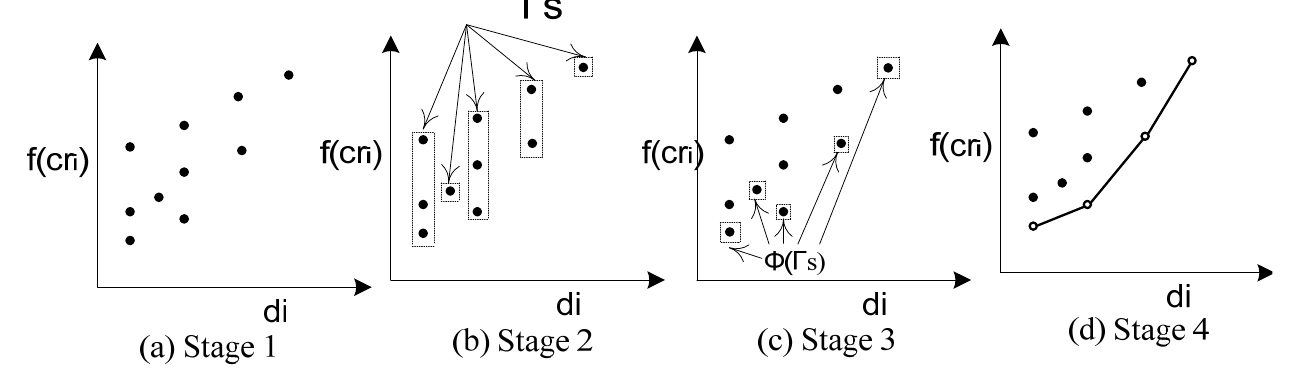
Figure 5. Identification of hyper-rectangles.